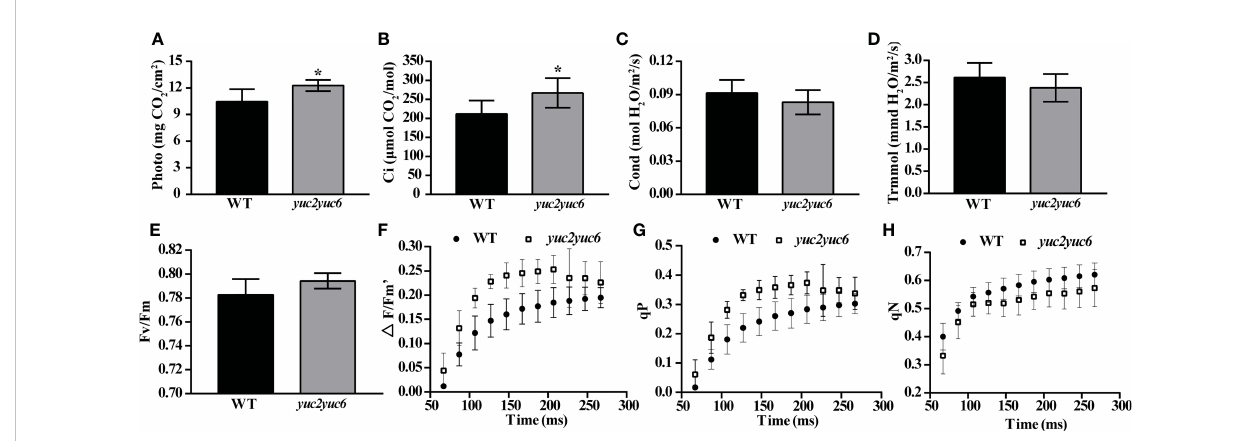
FIGURE 3 Improved photosynthesis in yuc2 yuc6 . (A) Photosynthetic rate. (B) Intercellular CO 2 concentration. (C) Stomatal conductance. (D) Transpiration rate. (E) Maximum quantum yield Fv/Fm ratio. (F) Real-time photosynthetic ef fi ciency. (G) Photochemical quenching coef fi cient. (H) Non-photochemical quenching coef fi cient. * represents p value